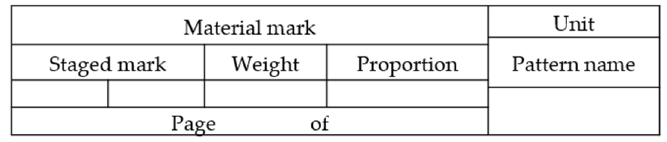
Figure 2. The CAD (Computer Aided Design) engineering drawings with table crossing lines.